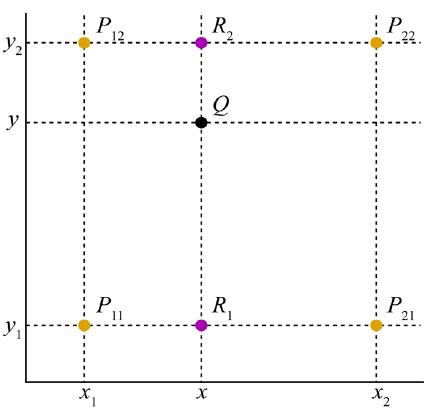
Figure 7. Schematic graph of bilinear